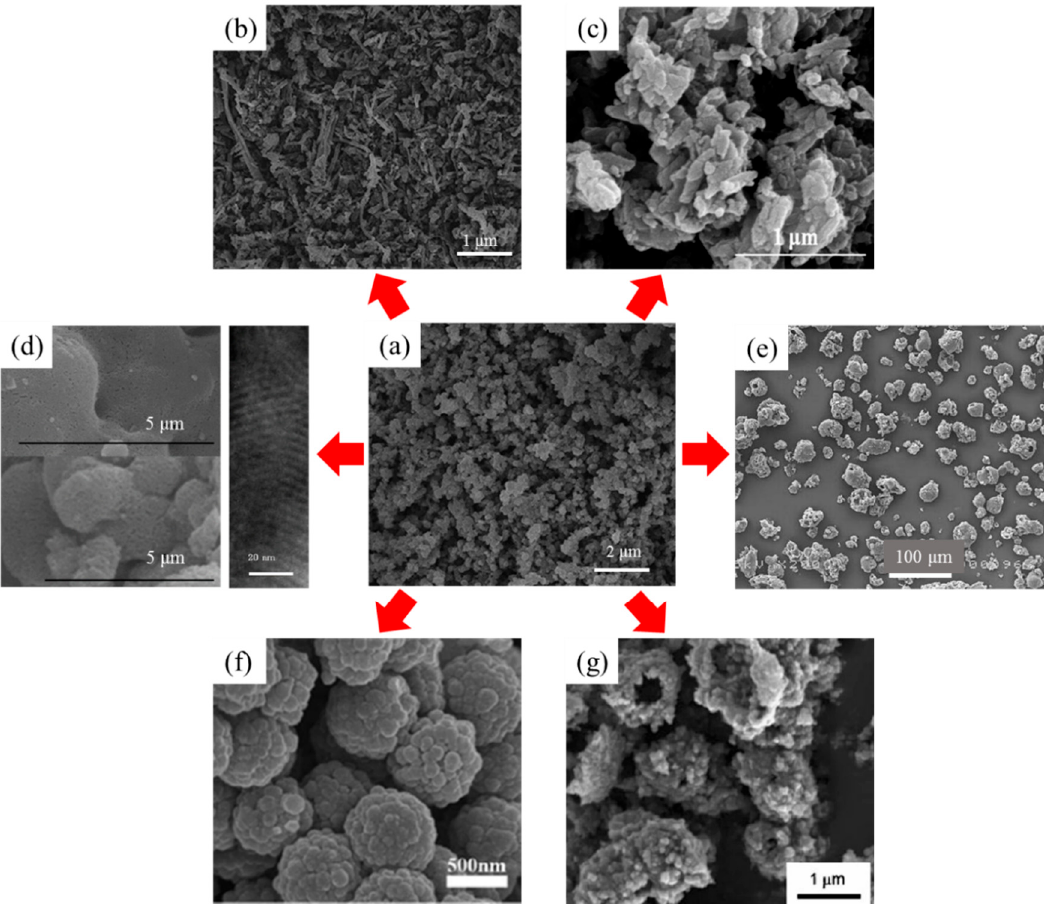
Figure 2. SEM morphologies of polypyrrole (PPy) and its composites: ( a ) granular PPy and ( b ) PPy nanofibers, reprinted with permission from [39]. Copyright Elsevier, 2011; ( c ) PPy-HNT particles, reprinted with permission from [41]. Copyright Springer Nature, 2014; ( d ) PPy/MCM-41